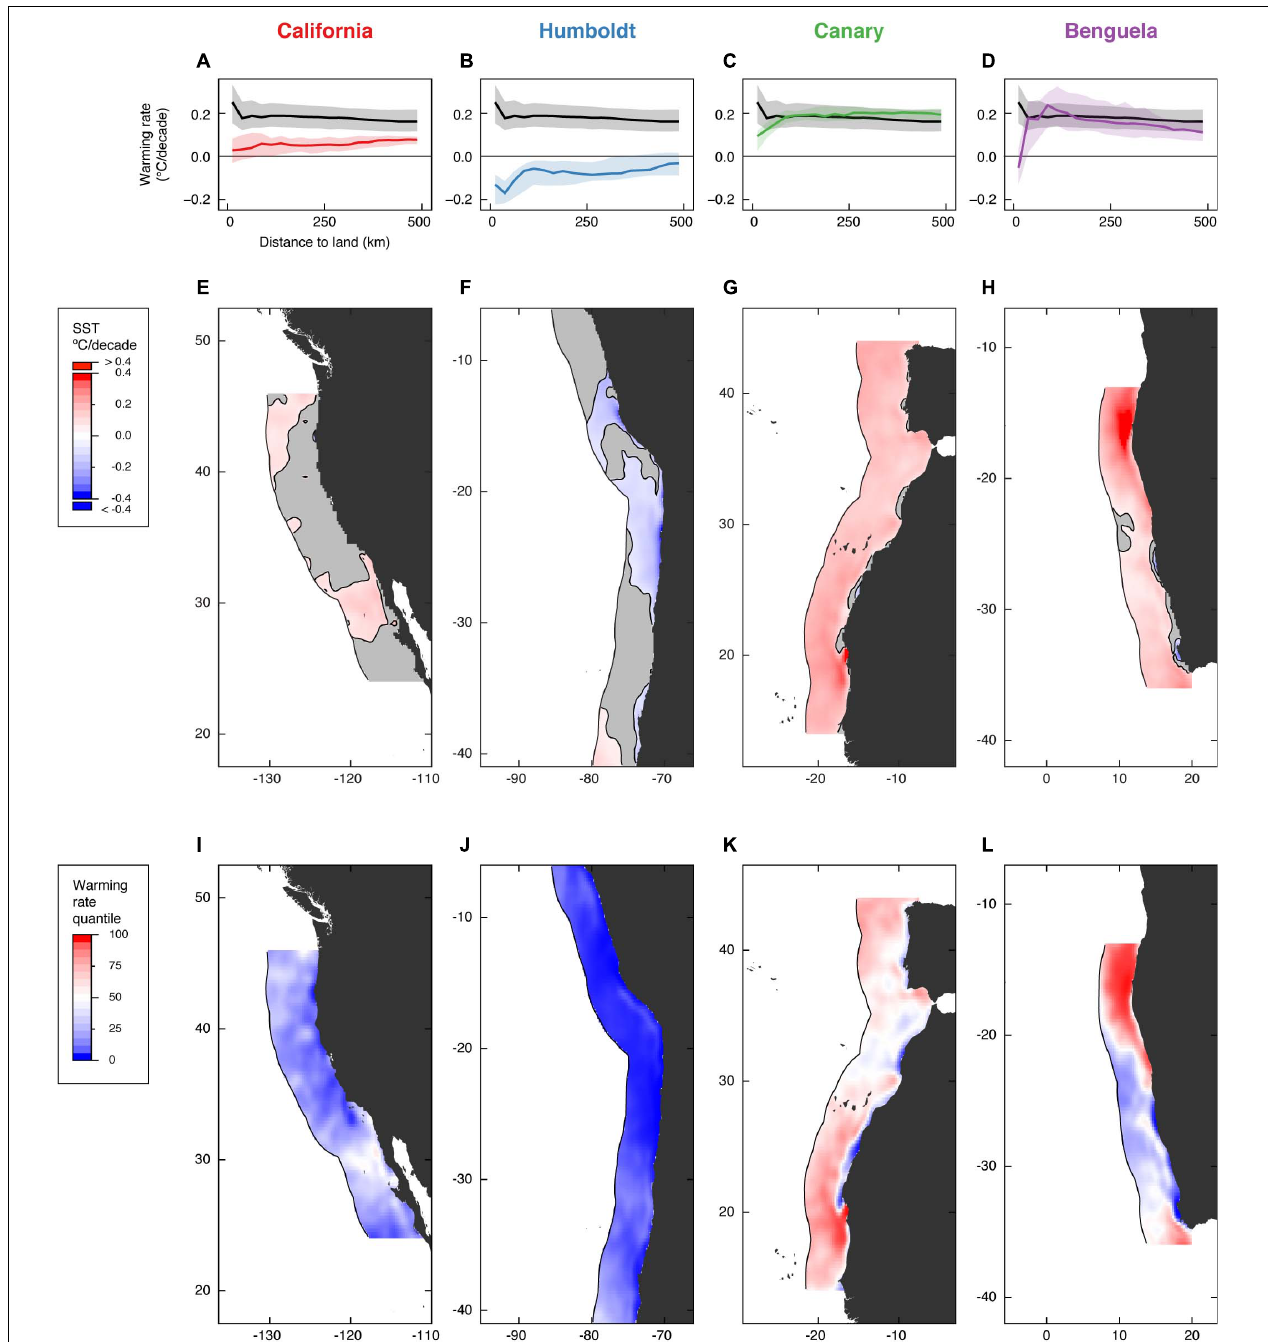
FIGURE 2 | Patterns of SST warming along the coastal ocean (up to 500 km from major landmasses) inside EBUS. Area-weighted warming rate averages for each 25 km distance bin show that while warming has been fastest toward the nearshore in non-EBUS (black line over gray shade), the opposite occurred in all EBUS ( A–D ; lines correspond to the median and shaded areas represent the interquartile range). The reduced warming along the nearshore is also evident in the detailed views of the SST warming rates inside EBUS (E–H) and their ranking relative to the warming rates found in the entire global ocean between 60 ◦ N and 60 ◦ S (I–L) . Gray areas in panels E–H correspond to statistically non-significant rates of SST change at the α = 0.05 level.